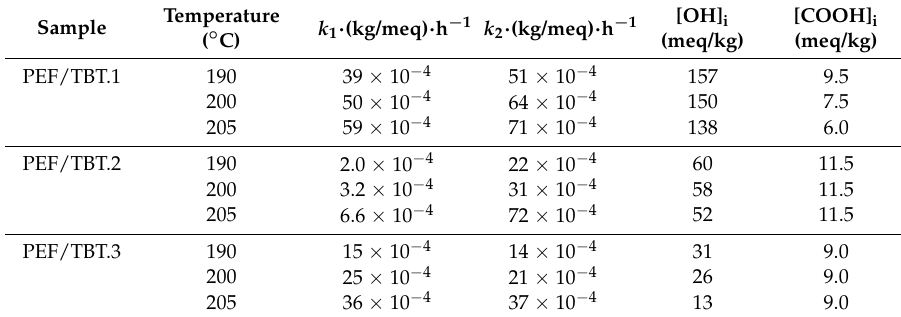
Figure 4. Variation of hydroxyl end-groups with time during PEF/TBT.1 ( a ), PEF/TBT.2 ( b ), and PEF/ TBT.3 ( c ) SSP at different temperatures. Continuous lines represent the theoretical kinetic model simulation results. Table 2. Kinetic rate constants of the transesterification and esterification reaction and concentration of temporarily inactivated OH and COOH end-groups at different polycondensation temperatures of PEF/TBT.1, PEF/TBT.2, and PEF/TBT.3.